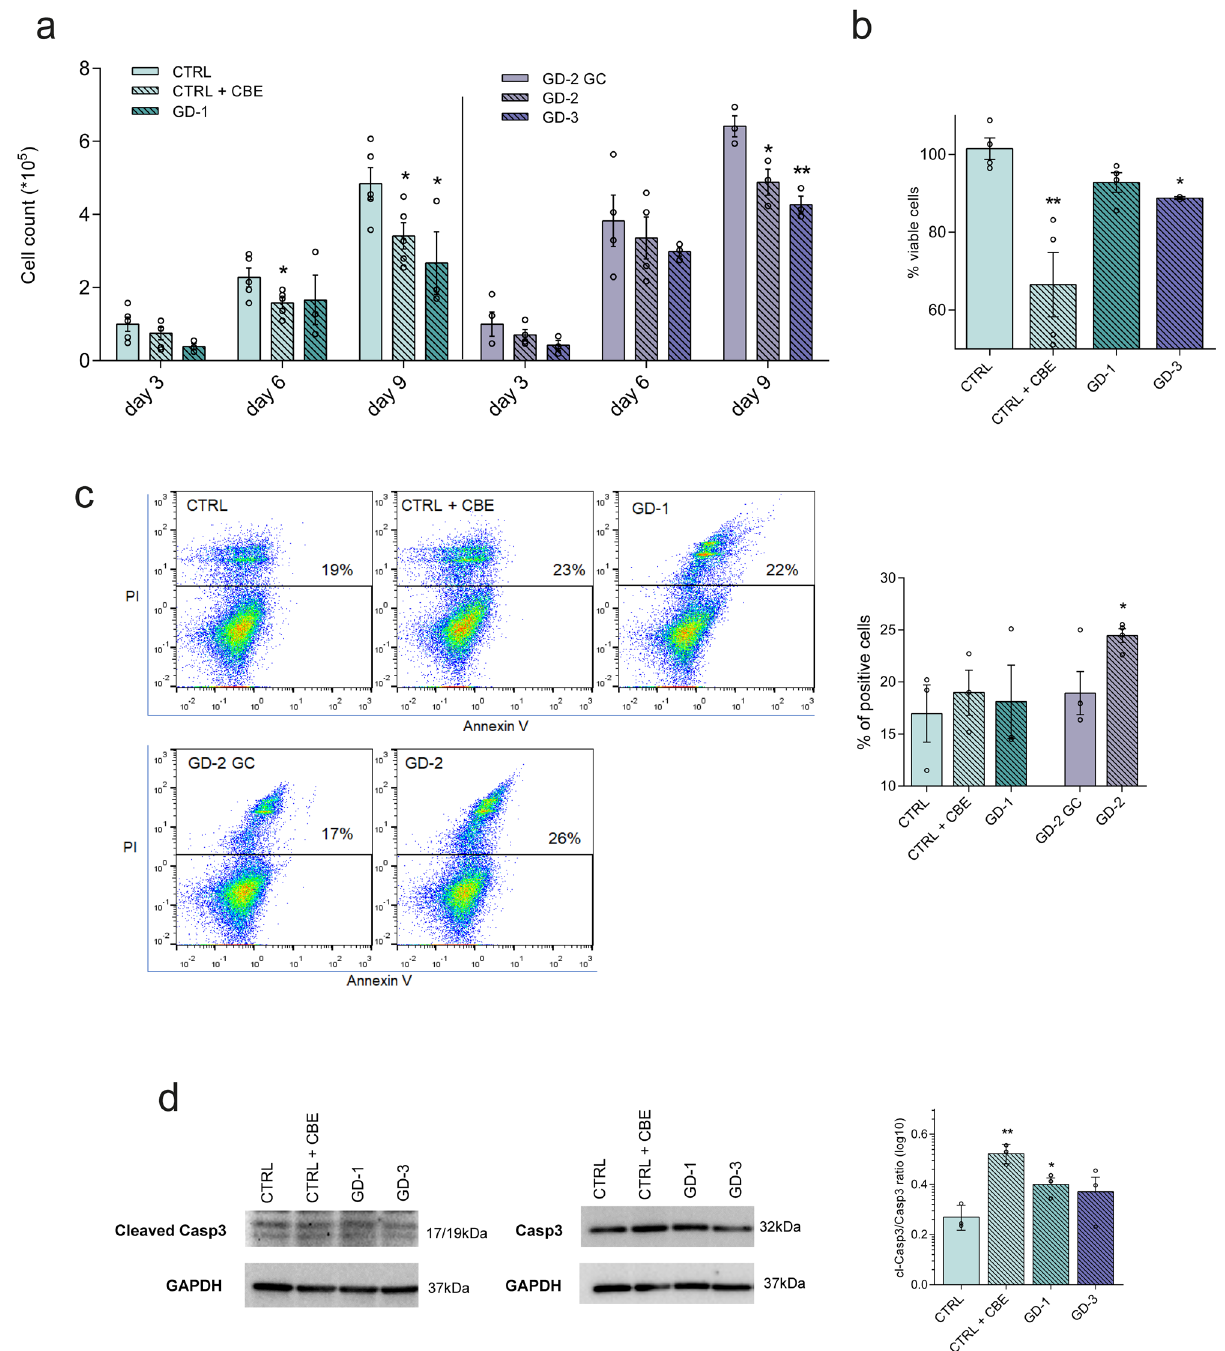
Fig. 3 GD NPCs show growth de fi cit and increased cell death. a Evaluation of the cell count of untreated and CBE-treated CTRL and the three GD patients ’ NPCs after 3, 6, and 9 days in culture. Cells have been seeded in NPC medium and kept in culture to evaluate the absolute number at the different time points ( n = 3). CBE-treated and GD-1 NPCs display a signi fi cant decrease in cell number after 9 days in culture if compared with CTRL, the same effect is evident also for the two neuronopathic lines compared with the isogenic gene-corrected (GD-2 GC) NPCs. b Quanti fi cation of absorbance released by metabolic active NPCs after MTT assay, as a direct indicator of viable and proliferating cells. The percentage has been calculated on the media of CTRLs ( n = 4). c Flow cytometry evaluation of NPCs stained with AnnexinV (FITC) and PI after 7 days in culture in standard NPC medium. The quanti fi cation of the PI marker positivity suggests a strong effect in cell death induction in the nGD line (GD-2) analysed in this experiment ( n = 3). d Representative Western blot of cleaved Caspase 3 (cleaved Casp3) and total Caspase 3 (Casp3) in GD NPCs (GD-1, GD-3, and CBE treated) and corresponding control (CTRL) with the relative quanti fi cation of cleaved Caspase 3/caspase 3 ratio ( n = 3). All graphs show mean values and SEM, and statistical signi fi cance is indicated as p value (Student ’ s t -test), * p < 0.05, ** p <